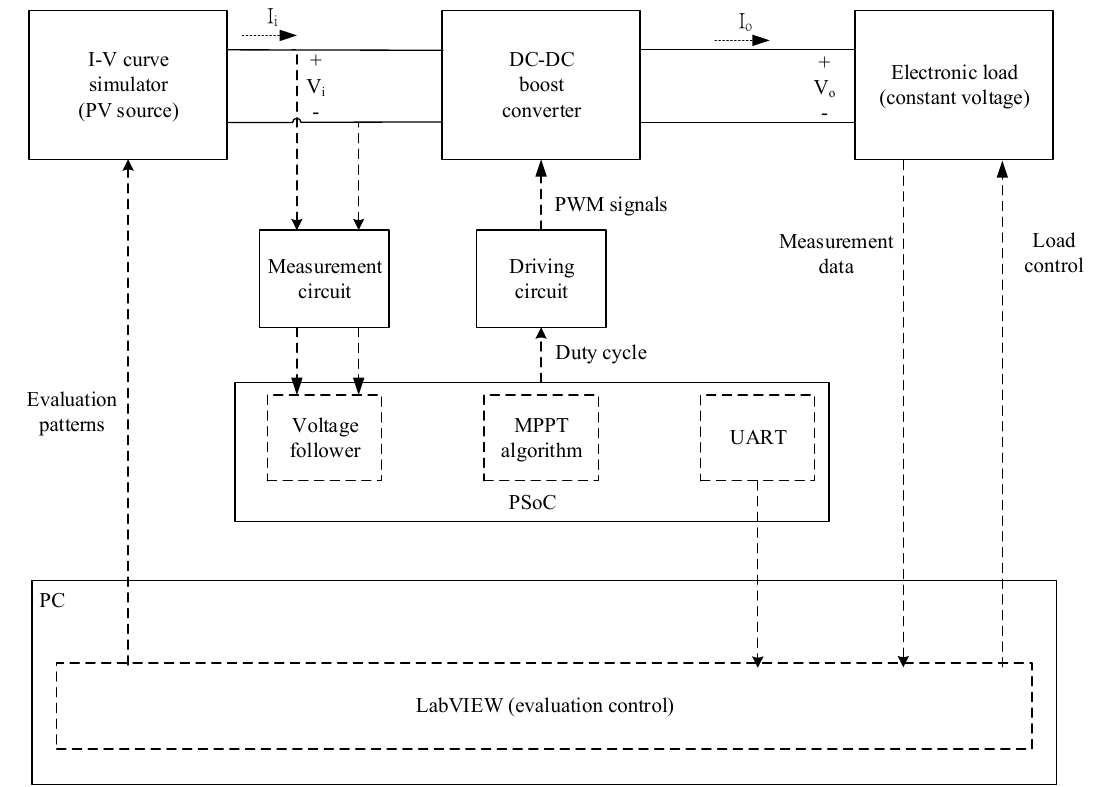
Figure 15. Evaluation system structure. Table 13. Specifications of the boost converter.